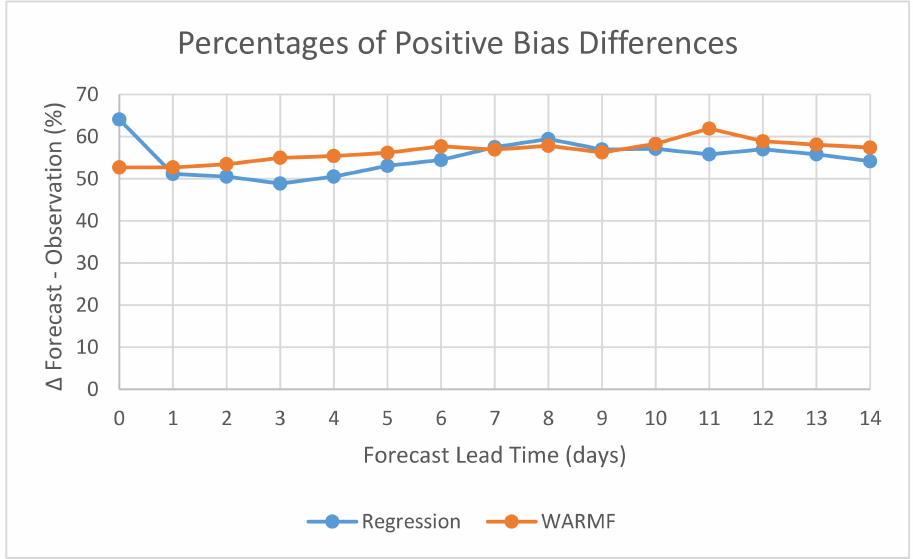
Figure 10. Comparison of the percentages of higher (positive bias) EC forecasts for the Regression and WARMF models for the period between 22 February 2018 and 22 May